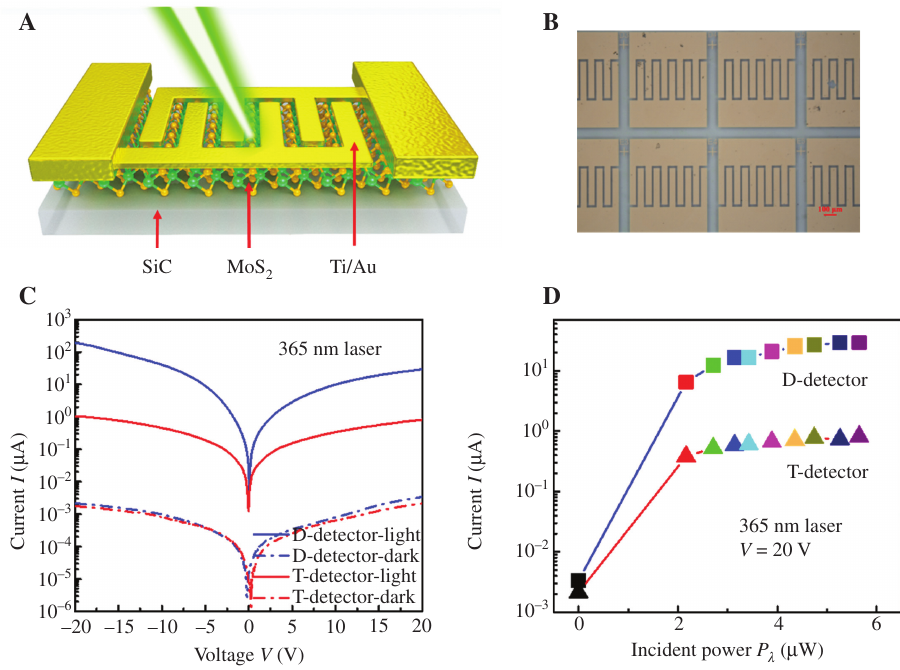
/SiC photodetector. 2 /SiC photodetector, in which the electrodes is Ti/Au. (B) Optical microscope image of MoS 2